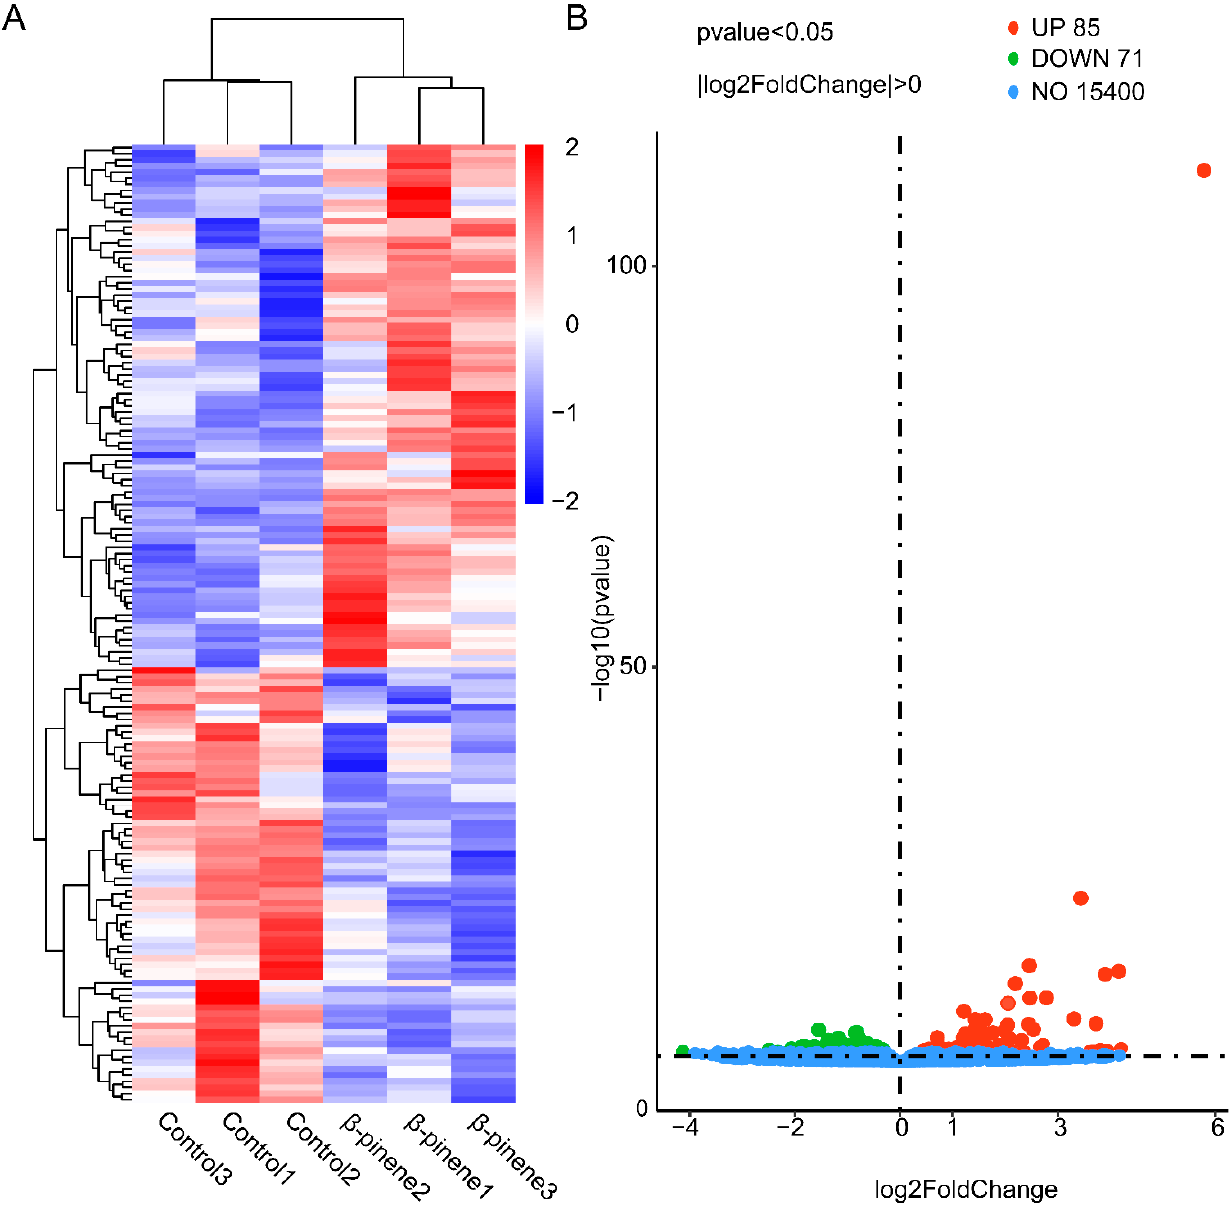
Figure 3. Transcriptome analysis of dauer juveniles (J IV ) of Bursaphelenchus xylophilus promoted by β -pinene. ( A ) Heat map of differently expressed genes (DEGs), analyzed through the transcriptome of B. xylophilus J IV promoted by β -pinene. ( B ) Volcano plot of DEGs analyzed through the transcriptome of B. xylophilus J IV promoted by β -pinene.